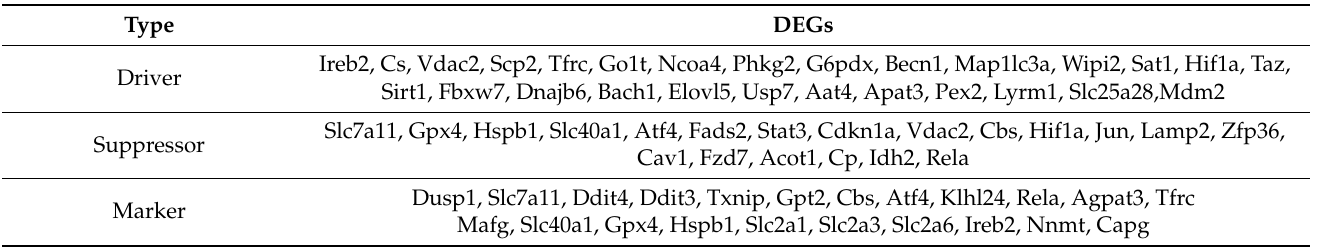
Table 2. Details of DEGs related to